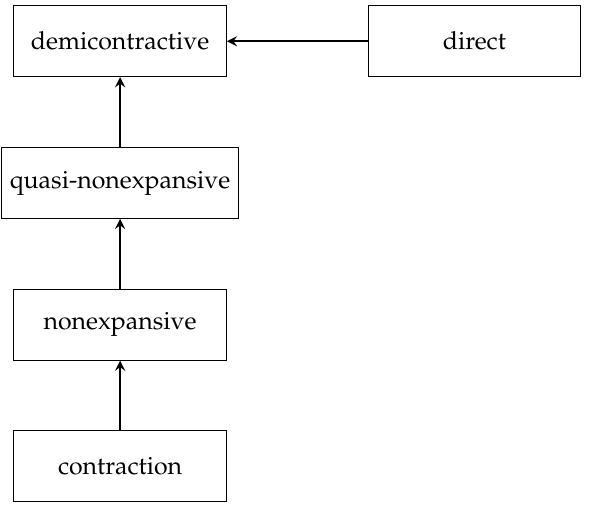
Figure 1. Diagram relations